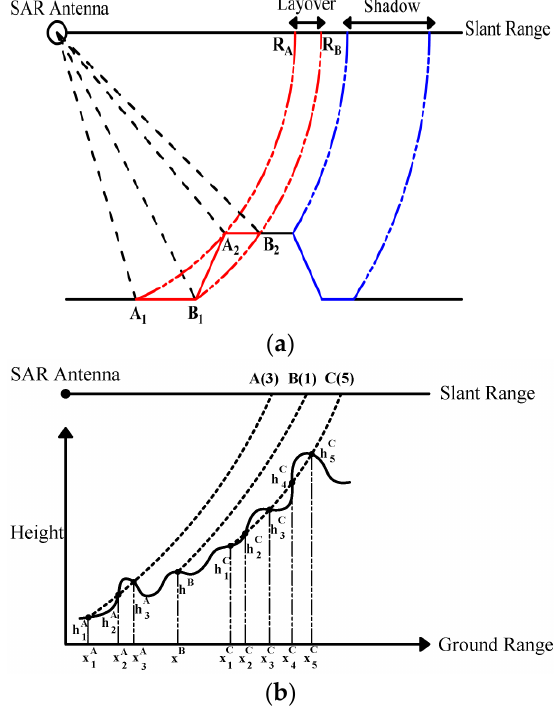
Figure 4. Concept of ( a ) layover and shadow; ( b ) layover topographic correction method.